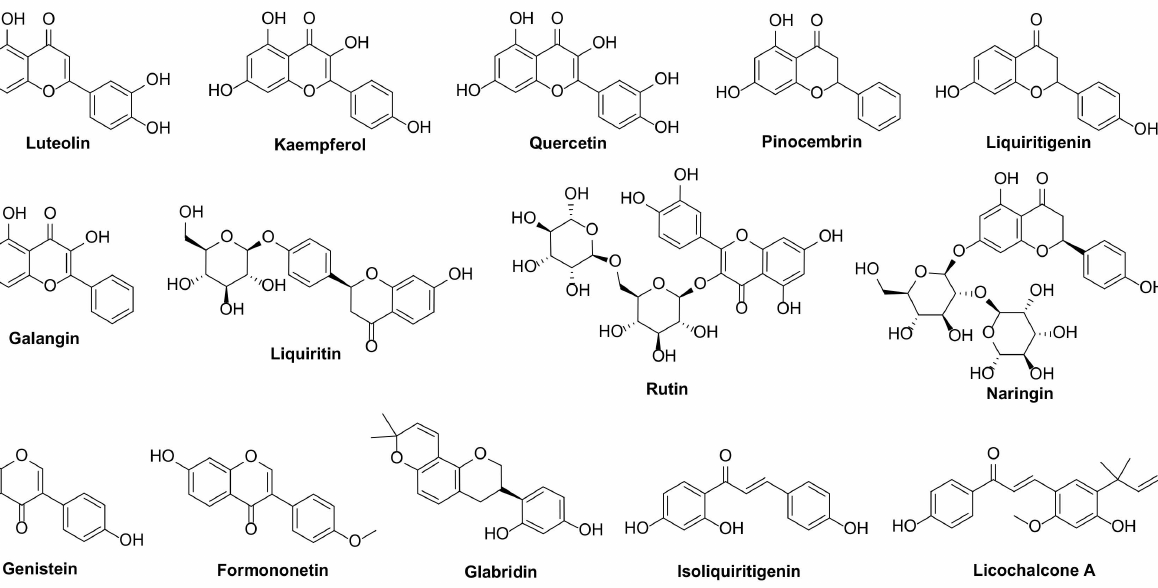
Figure 1. Chemical structures of flavonoids, isoflavonoids and chalcones from Glycyrrhiza glabra